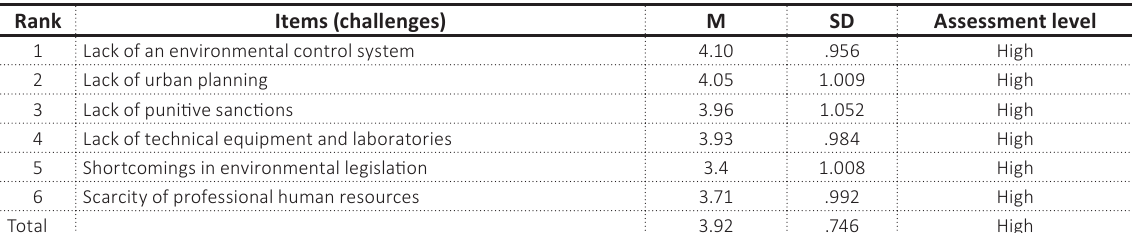
Table 3. Respondents’ assessment of environmental protection challenges facing local